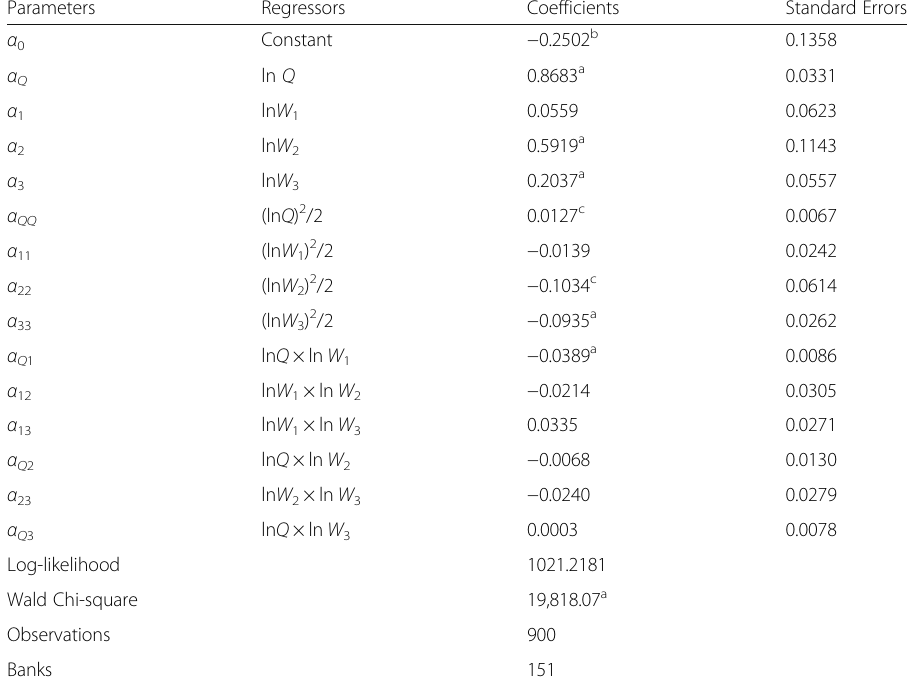
Table 6 Estimates of the cost